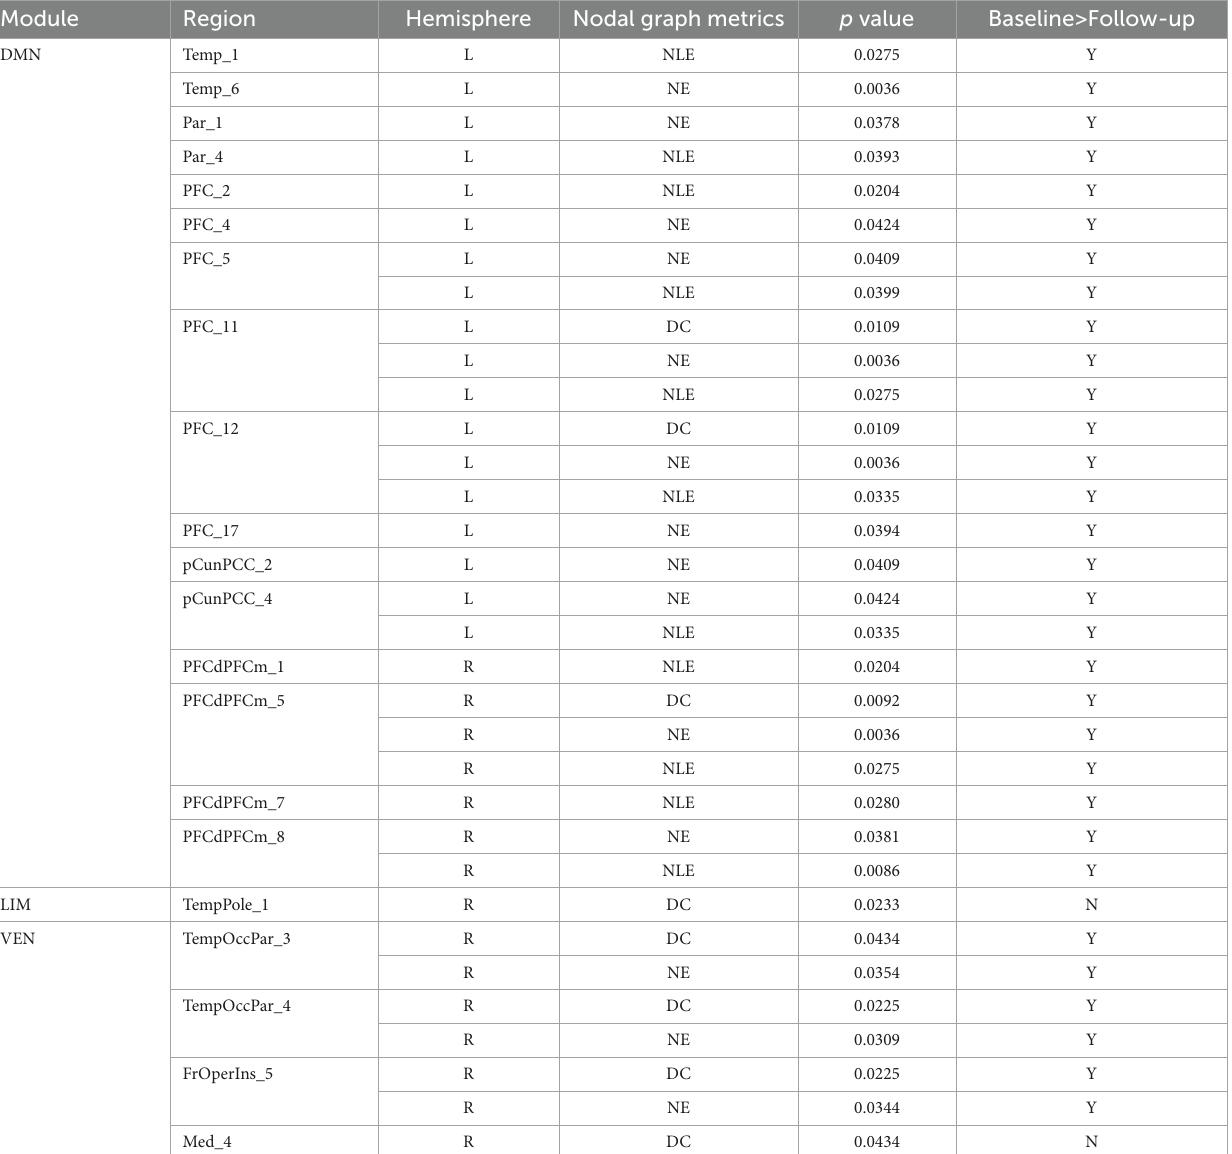
TABLE 2 Brain regions with graph metric changes after 1 year follow-up among EPRT- group (FDR corrected). Module Region Hemisphere Nodal graph metrics p value Baseline >